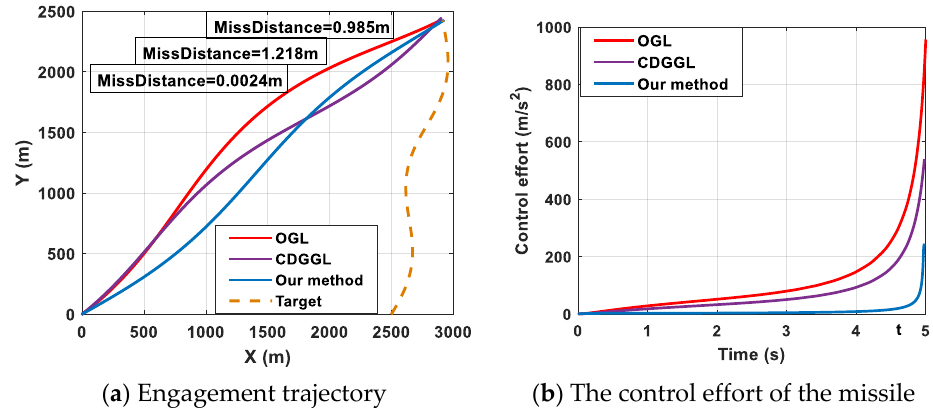
Figure 12. Engagement scenario and the control effort of the missile.